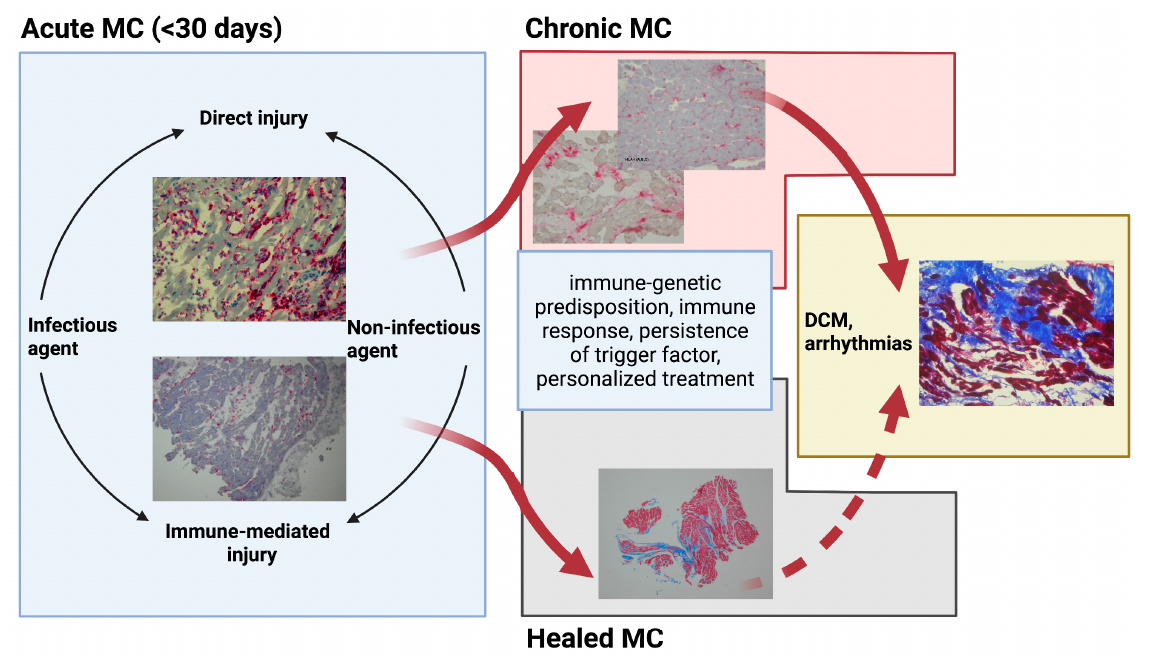
Figure 1. Pathogenesis and natural course of myocarditis. DCM: dilated cardiomyopathy; MC: myocarditis. Created with BioRender.com (accessed on 4 January